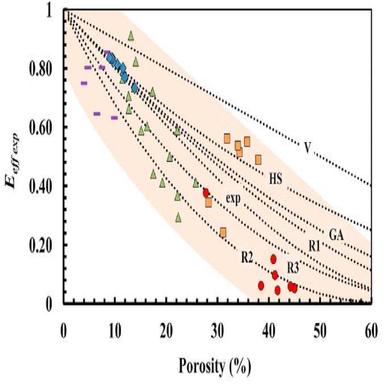
Effective Young's modulus as a function of porosity p. Experimental data are indicated with points and analytical estimates by dotted-lines. Samples A (Novais, Es = 6.8 GPa), samples B-IS (De Bonis, Es = 20 GPa), samples B–SO (De Bonis, Es = 20 GPa), samples C (Márquez, Es = 76 GPa) and samples D (Gültekin, Es = 76 GPa). Calculations are performed by using: Hashin-Shtrikman (HS), equation Voigt (V), equation; expone